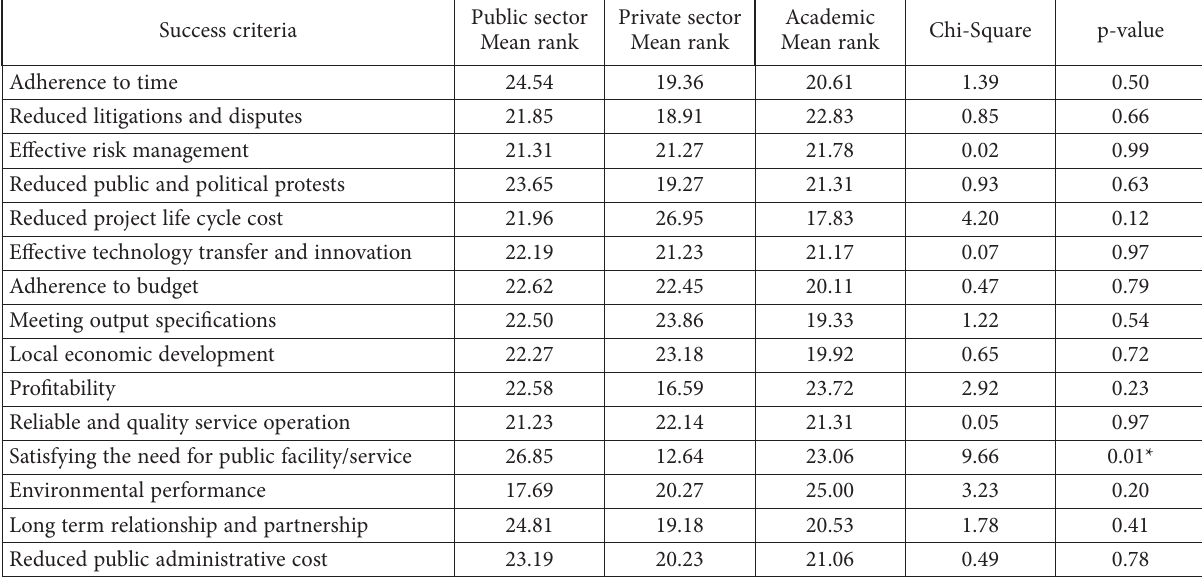
Table 7. Results of Kruskal Wallis test on the rankings of success criteria for PPP projects among the public,